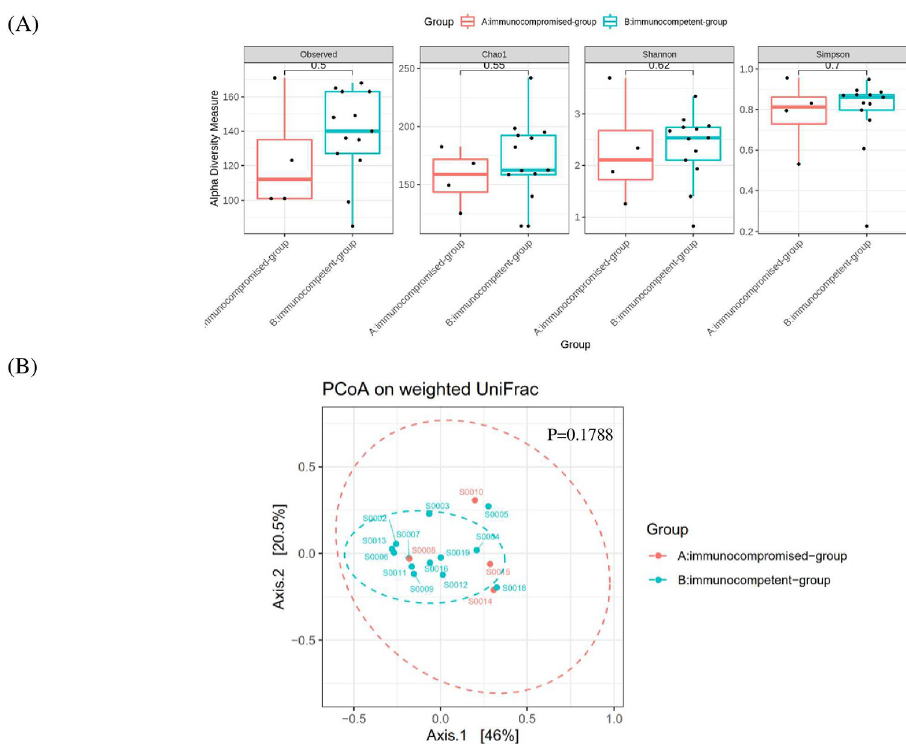
Fig 1. No significant difference in the community richness. (A) Alpha diversity between immunocompromised group and immunocompetent group with norovirus infection. (B) Beta diversity of bacterial communities between immunocompromised group and immunocompetent group with norovirus infection were calculated by the PCoA on weighted UniFrac.